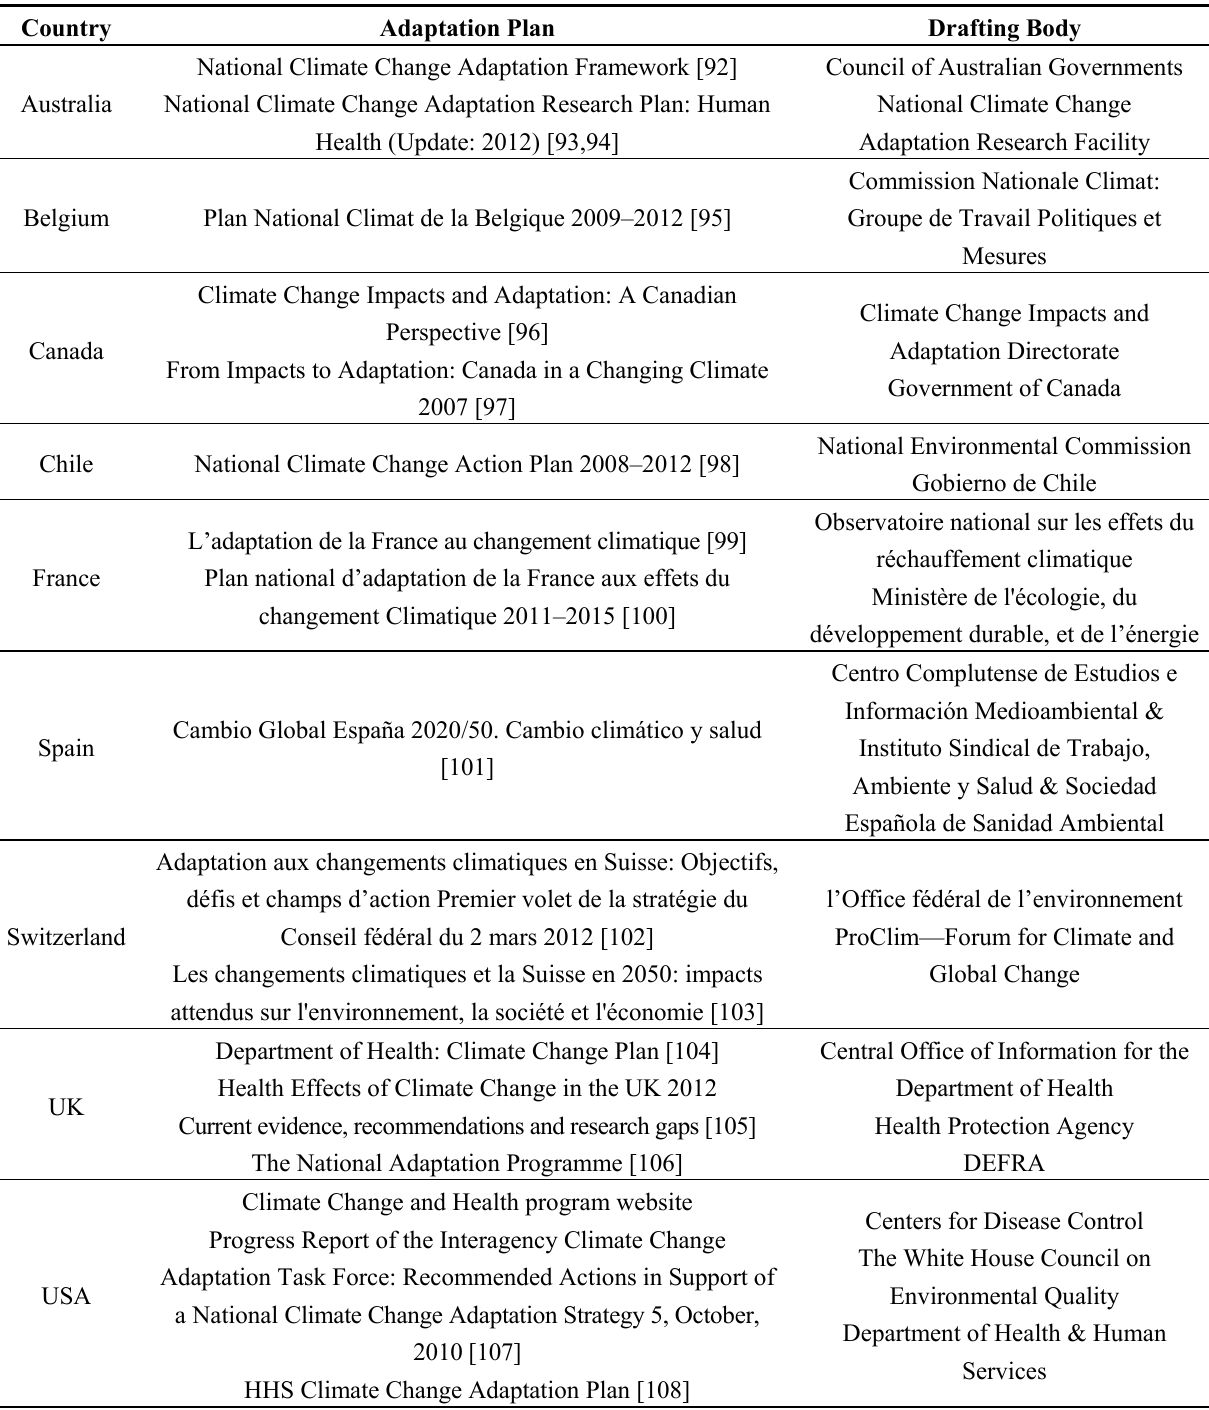
Table 4. National-Level adaptation planning documents reviewed in this